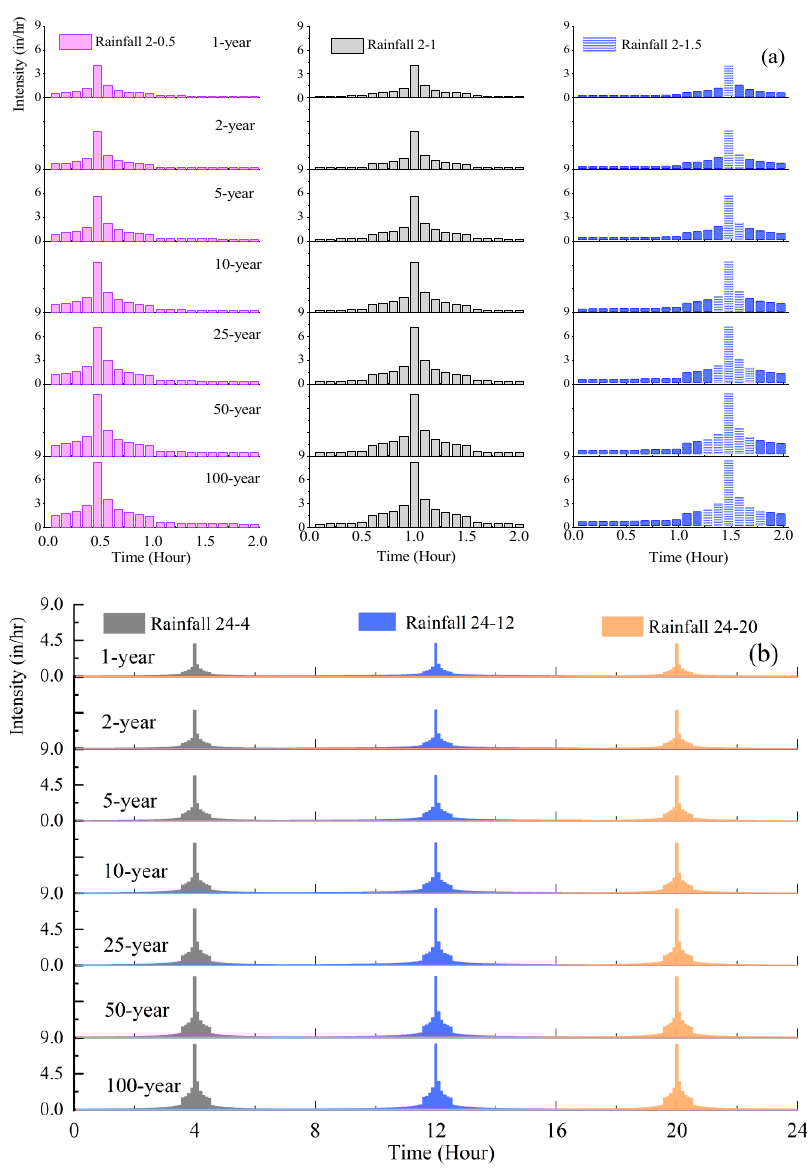
Figure 2. Synthetic rainfall distributions: ( a ): 2-h event, ( b ): 24-h event.